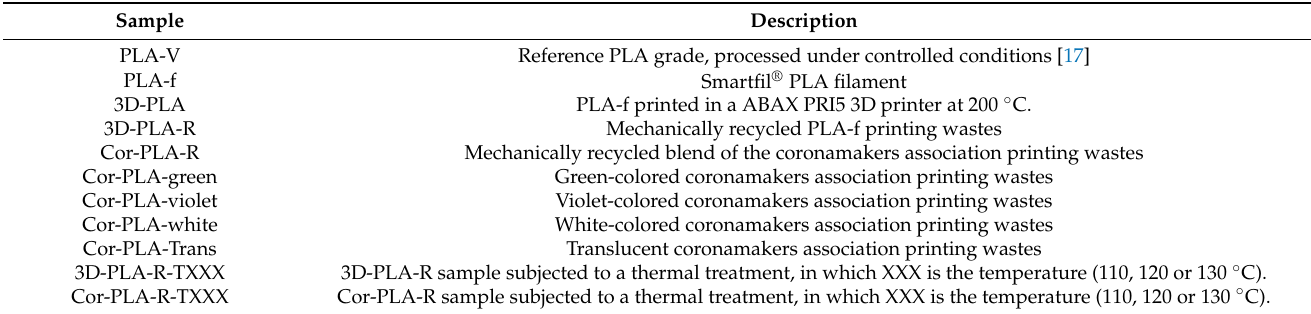
Table 1. Description of the materials used in this study.